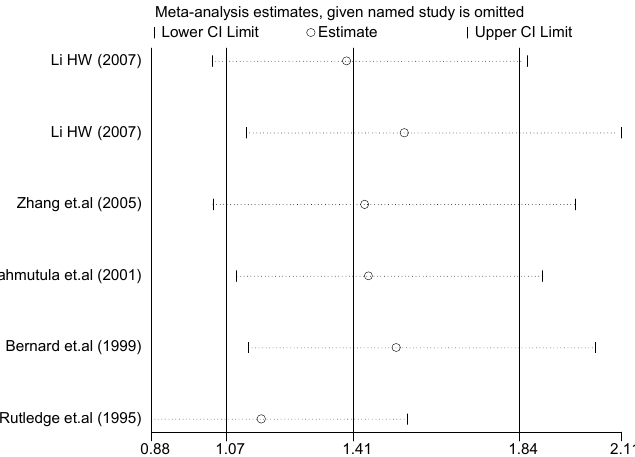
Figure 7. Forest plot of sensitivity analysis of overall population of G1837A polymorphism and EH (GA vs. GG).